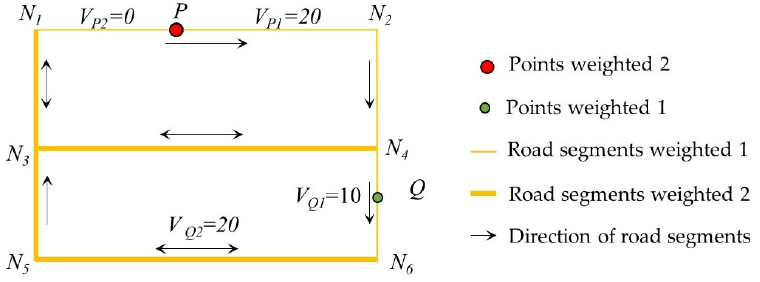
Figure 6. The speed of the auto-wave under constraints.